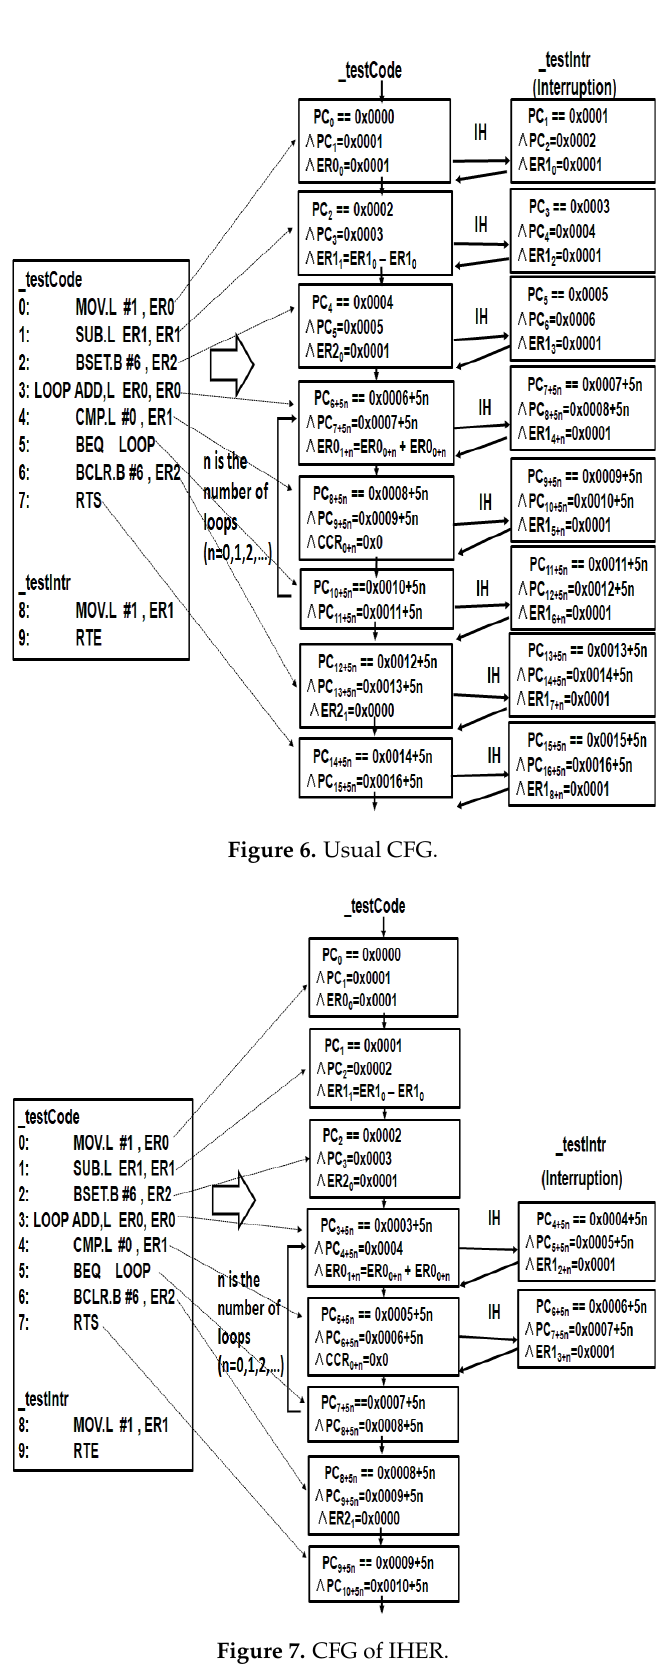
Figure 7. CFG of